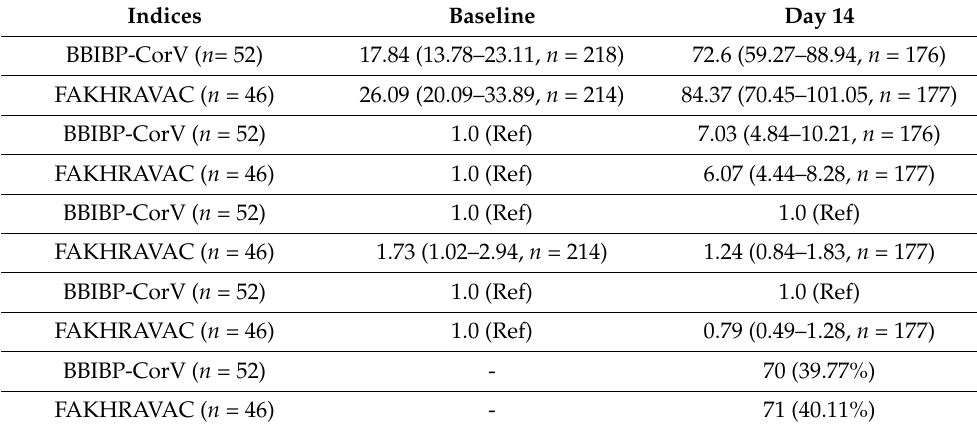
Table 4. Serum neutralizing antibody (Nab) indices in all participants. The GMT, GMFI, GMR, and GMFR are explained in the caption of Table 1. Superscripts of a, b, c represent the geometric mean of the amount of antibody in each vaccine, which was divided by the either amount of antibody in the baseline (Ref) day in the same vaccine group, the BBIBP-CorV (Ref) group on the same day, and changes of the two vaccines from the baseline (Ref), respectively.